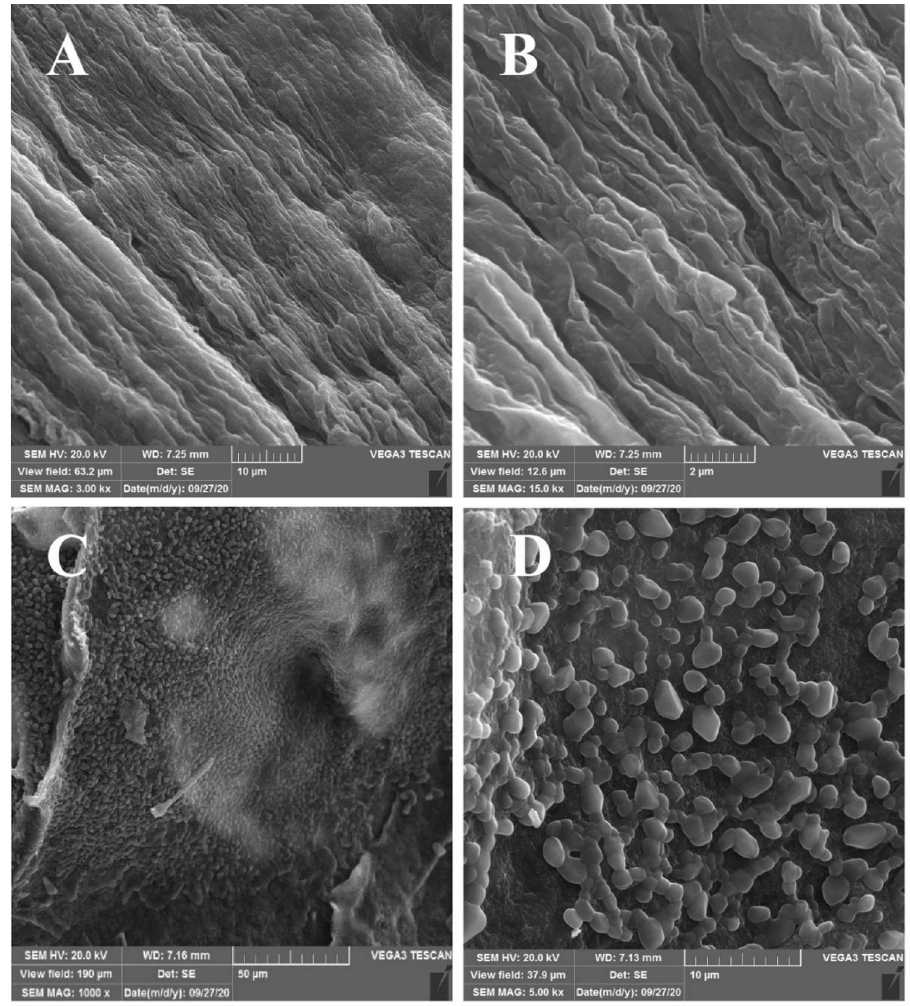
Figure 4. SEM analysis of non-transgenic and transgenic hairy roots. (A,B) Non-transgenic hairy roots with a wavy surface and free of any HA scaffolds on its surface. (C,D) SEM analysis of the transgenic hairy roots revealed a collection of irregular and small polygonal HA scaffolds on its